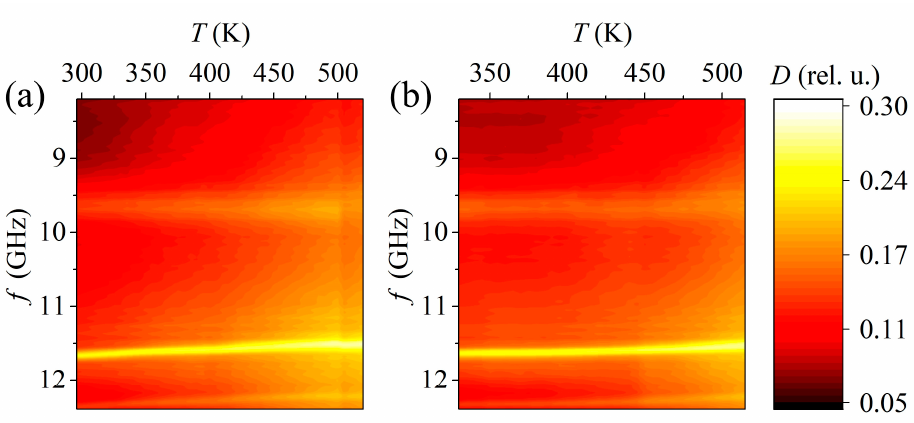
Figure 12. Dependence of the absorption coefficient of the measuring cell with a fixture on frequency and temperature during heating ( a ) and cooling ( b ).